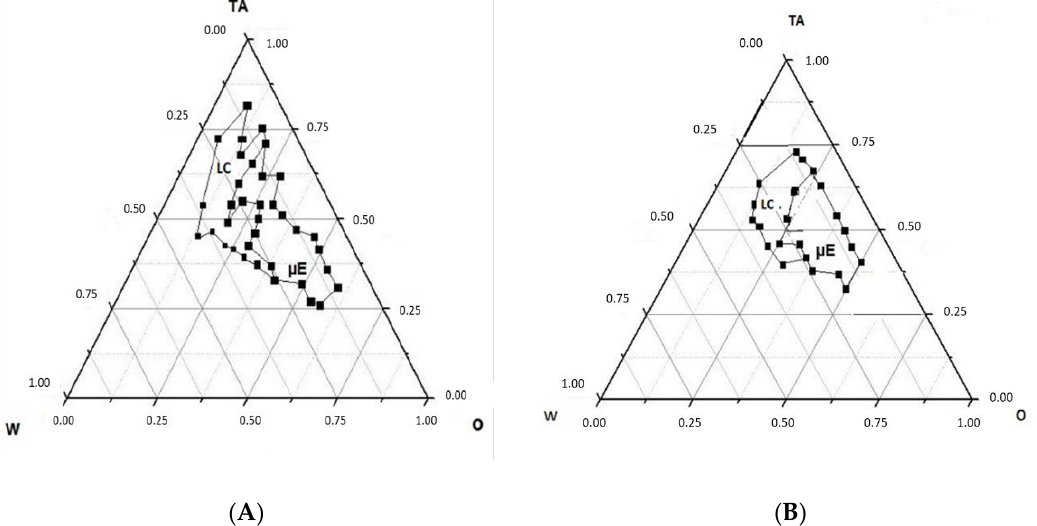
Figure 3 Figure 3. Pseudo-ternary phase diagram of the microemulsion (ME)–liquid crystal region (LC) system ( A ) without BVZ; ( B ) with BVZ.